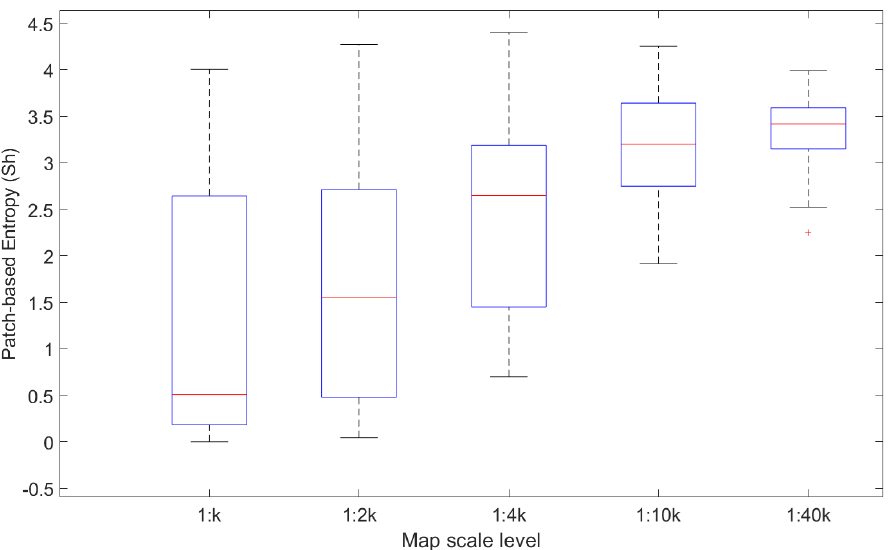
Figure 10. Box plots of the patch-based entropy for 100 sample images at five different scale levels. The red mark corresponds to the median, and the bottom and top edges indicate the 25th and 75th percentiles, respectively. The whiskers indicate extreme data points, and the outliers are denoted by a red cross symbol. The indicator is estimated based on probability of observing different mean RGB values for the 200 patches that are randomly generated with patchIT for each image (map).